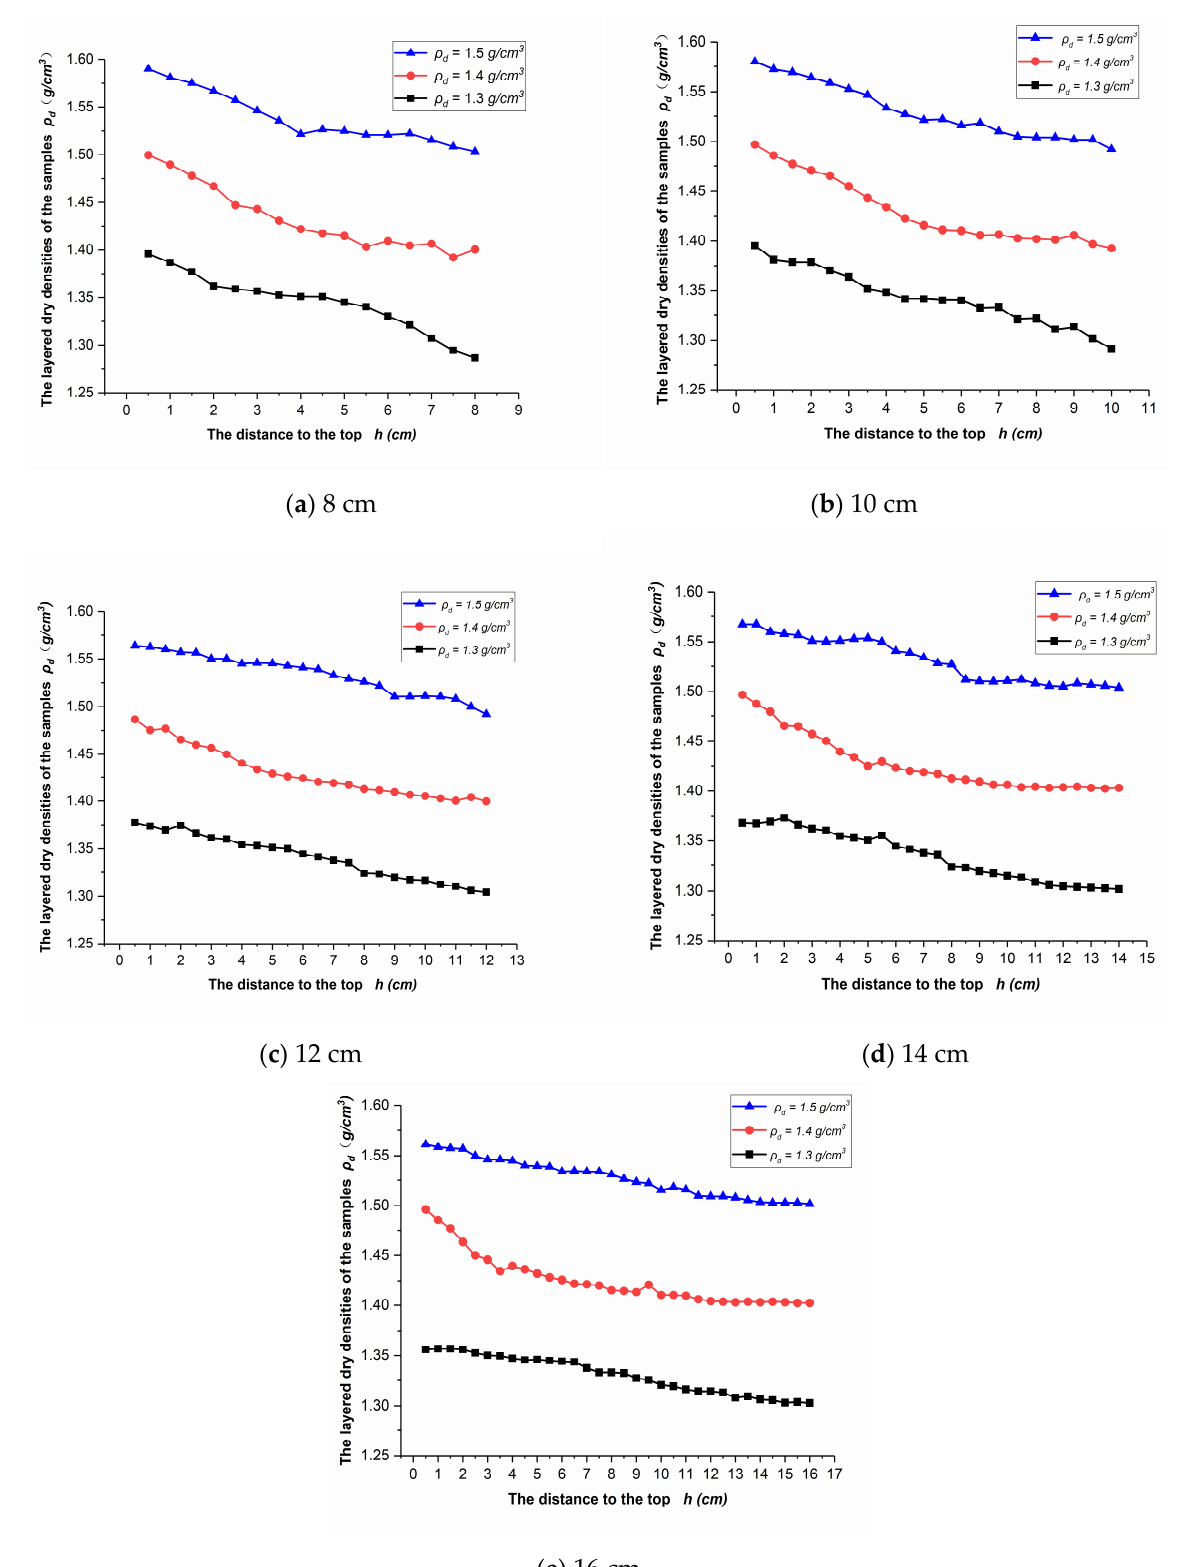
Figure 4. The variation in the dry density of the loess